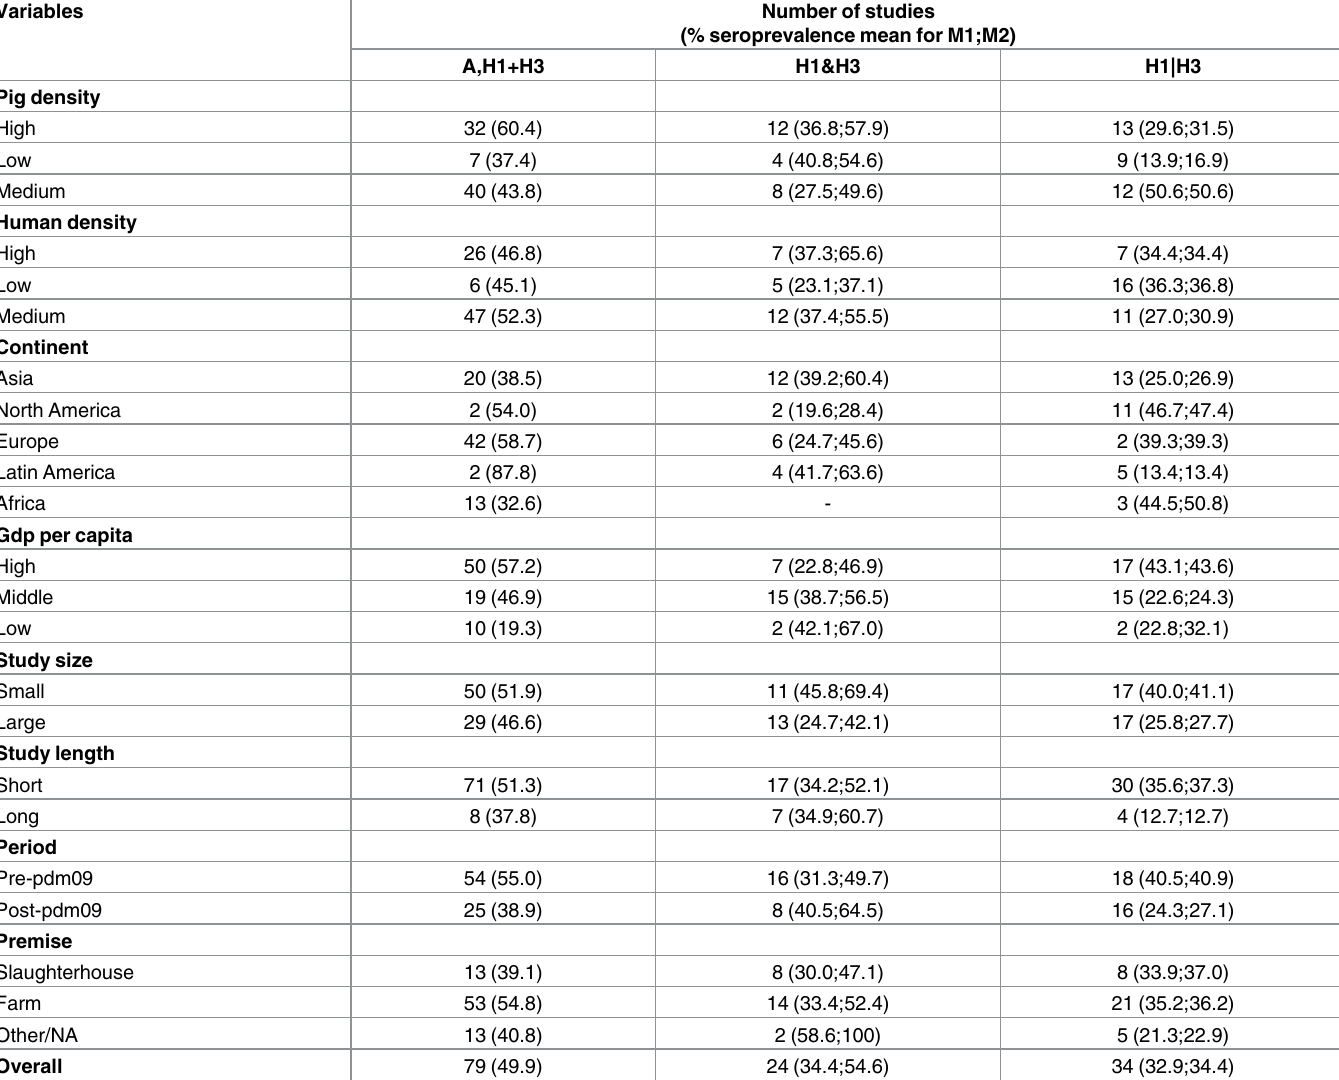
Table 1. Number of swine seroprevalence studies and seroprevalence means for the different variables.